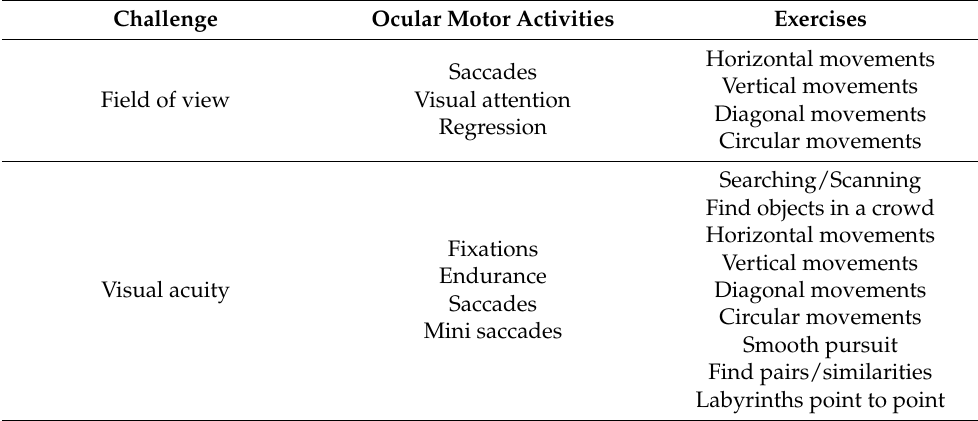
Table 2. Ocular motor activities connected to relevant training